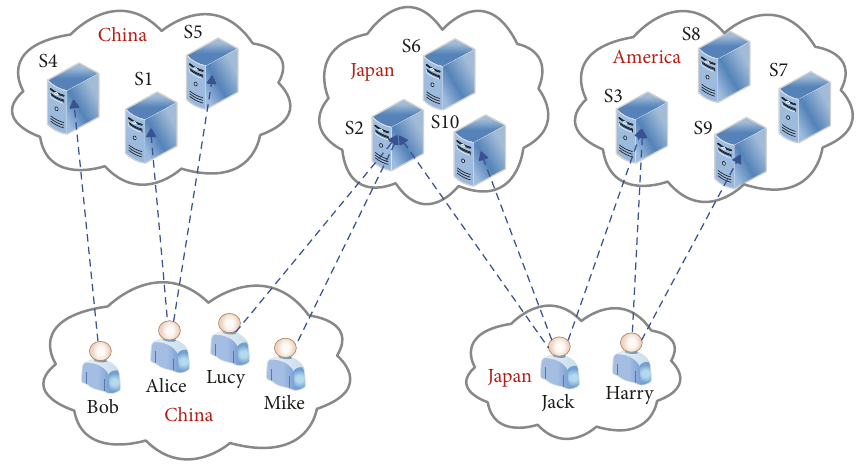
Figure 2: A toy example of the influence of the location